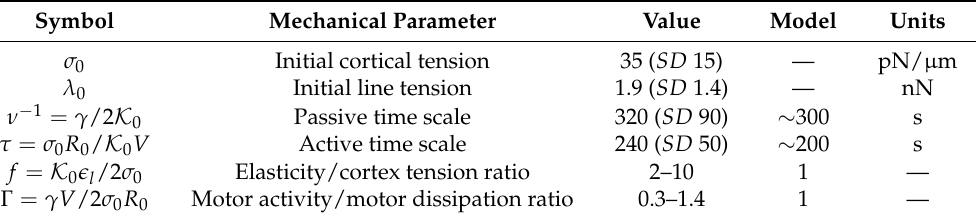
Table 1. Parameter values obtained from the numerical fit of Equation (10) and the experimental data using the integrated intensity of an SF segment of 5 µ m. Symbol Mechanical Parameter Value Model σ